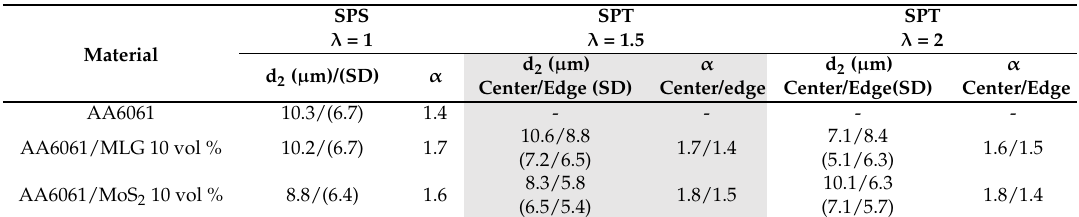
Table 3. Stereological parameters of composite structures after SPS and SPT processes, SD: Standard deviation.